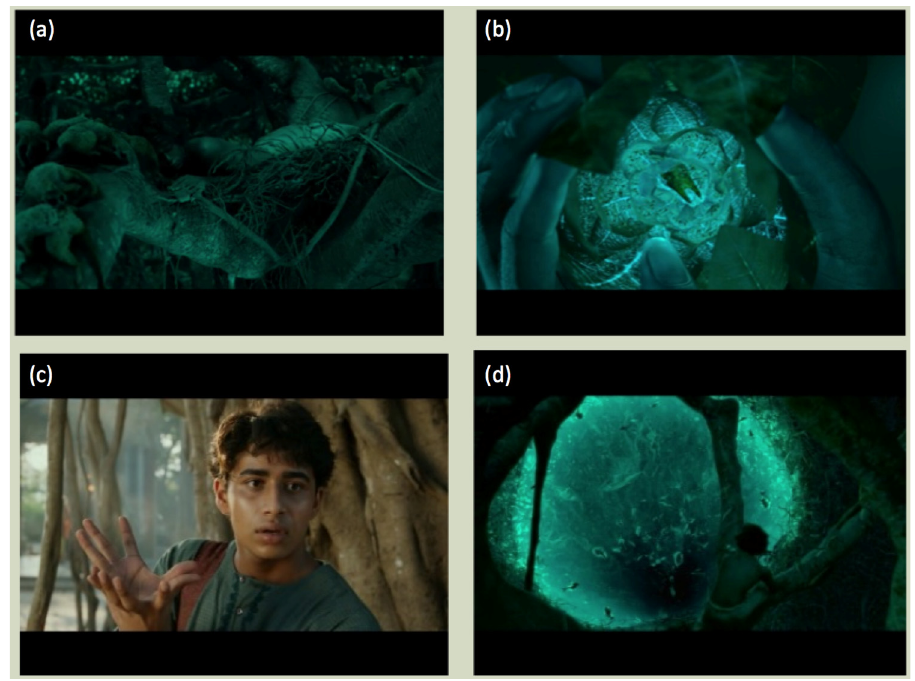
Figure 6. ( a ) Pi sleeps like a lotus in the banyan forest; ( b ) Pi finds a tooth in a lotus-like flower; ( c ) Pi holds his hands in a lotus gesture near a banyan tree; and ( d ) Pi peers into a deadly pool of water that resembles a lotus.